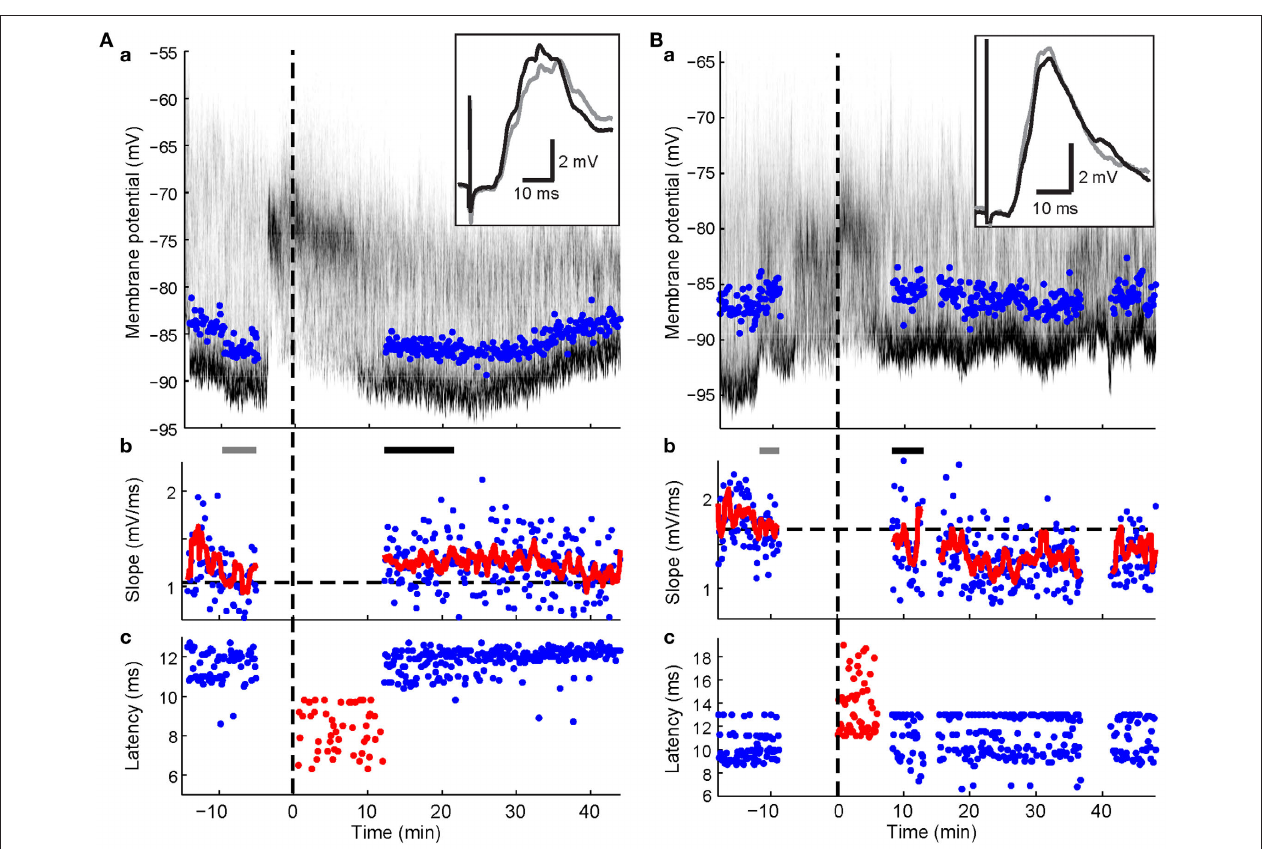
postsynaptic spike elicited by somatic current injection. Note spike latencies were relatively early compared to maximal slope latencies. (B) Example recording showing depression ( p = 0.038; Wilcoxon rank sum test) after pairing with current-evoked spikes following the maximal PSP slope. Note the relative higher frequency of later latency components after the